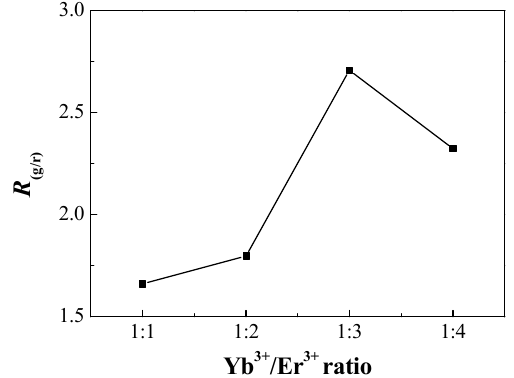
Fig. 8 Intensity ratio of the green emission to the red R in NLZ n ( n = 6, 7, 8, 9). emission   g/r